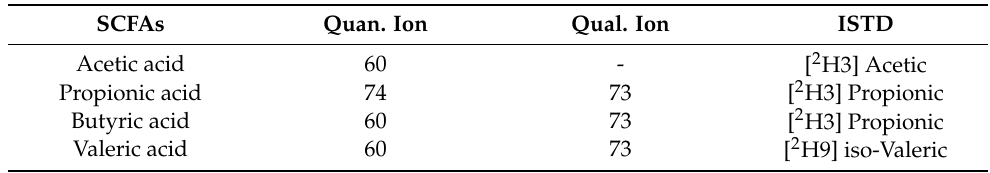
Table 2. The ionic signal used for quali/quantitation and relative ISTD of each Short Chain Fat Acids (SCFAs) acquired by the ID-GC-MS method. SCFAs Quan. Ion Qual. Ion ISTD Acetic acid 60 - [ 2 H3] Acetic Propionic acid 74 73 [ 2 H3] Propionic Butyric acid 60 73 [ 2 H3] Propionic Valeric acid 60 73 [ 2 H9]